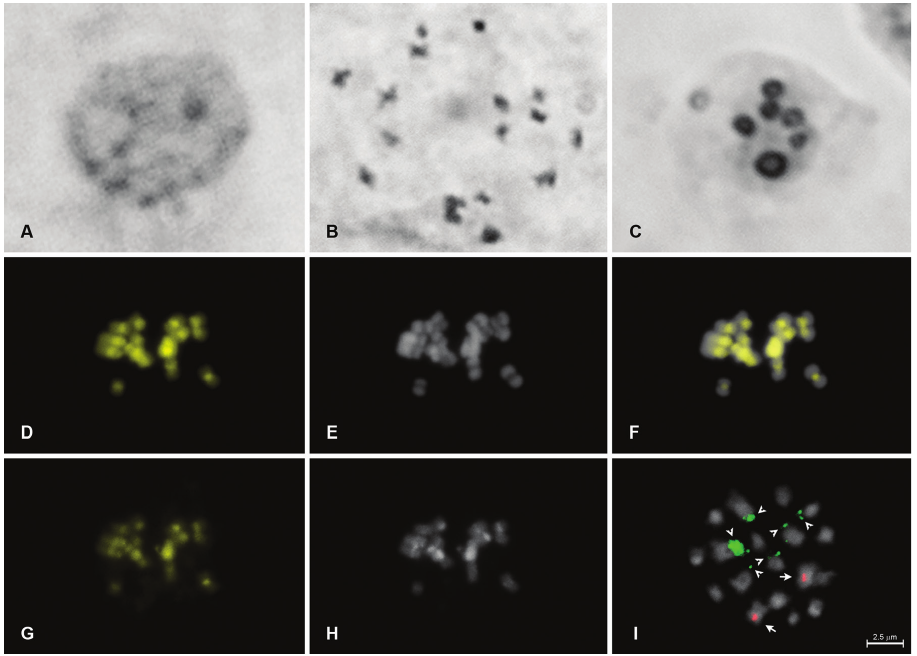
Figure 1. Karyotype analysis of Euphorbia hirta (2n = 18). Standard staining of mitotic interphase nucleus ( A ); standard staining of mitotic metaphase ( B ); silver impregnation of mitotic interphase nu- cleus ( C ); fluorochrome banding of metaphase chromosomes stained with CMA ( D ) and DAPI ( E ) and superposed images ( F ); C-banding of chromosomes stained with CMA/DAPI (C-CMA/DAPI; G–H ); and metaphase chromosomes hybridized with 5S (red) and 45S (green) rDNA probes ( I ). Arrows and arrowheads indicate 5S and 45S rDNA sites,